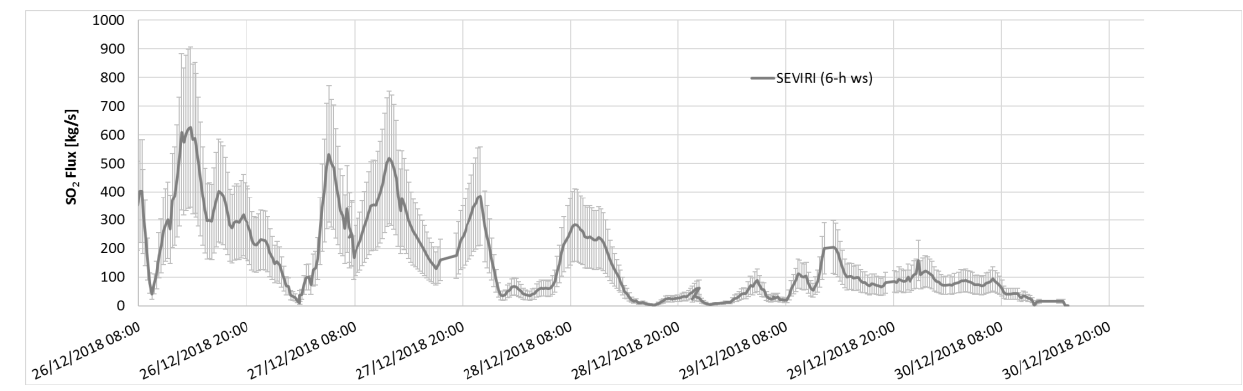
Figure 13. SEVIRI SO 2 flux. The uncertainty derives from the sum of the SO 2 columnar abundance and VPTH uncertainties.